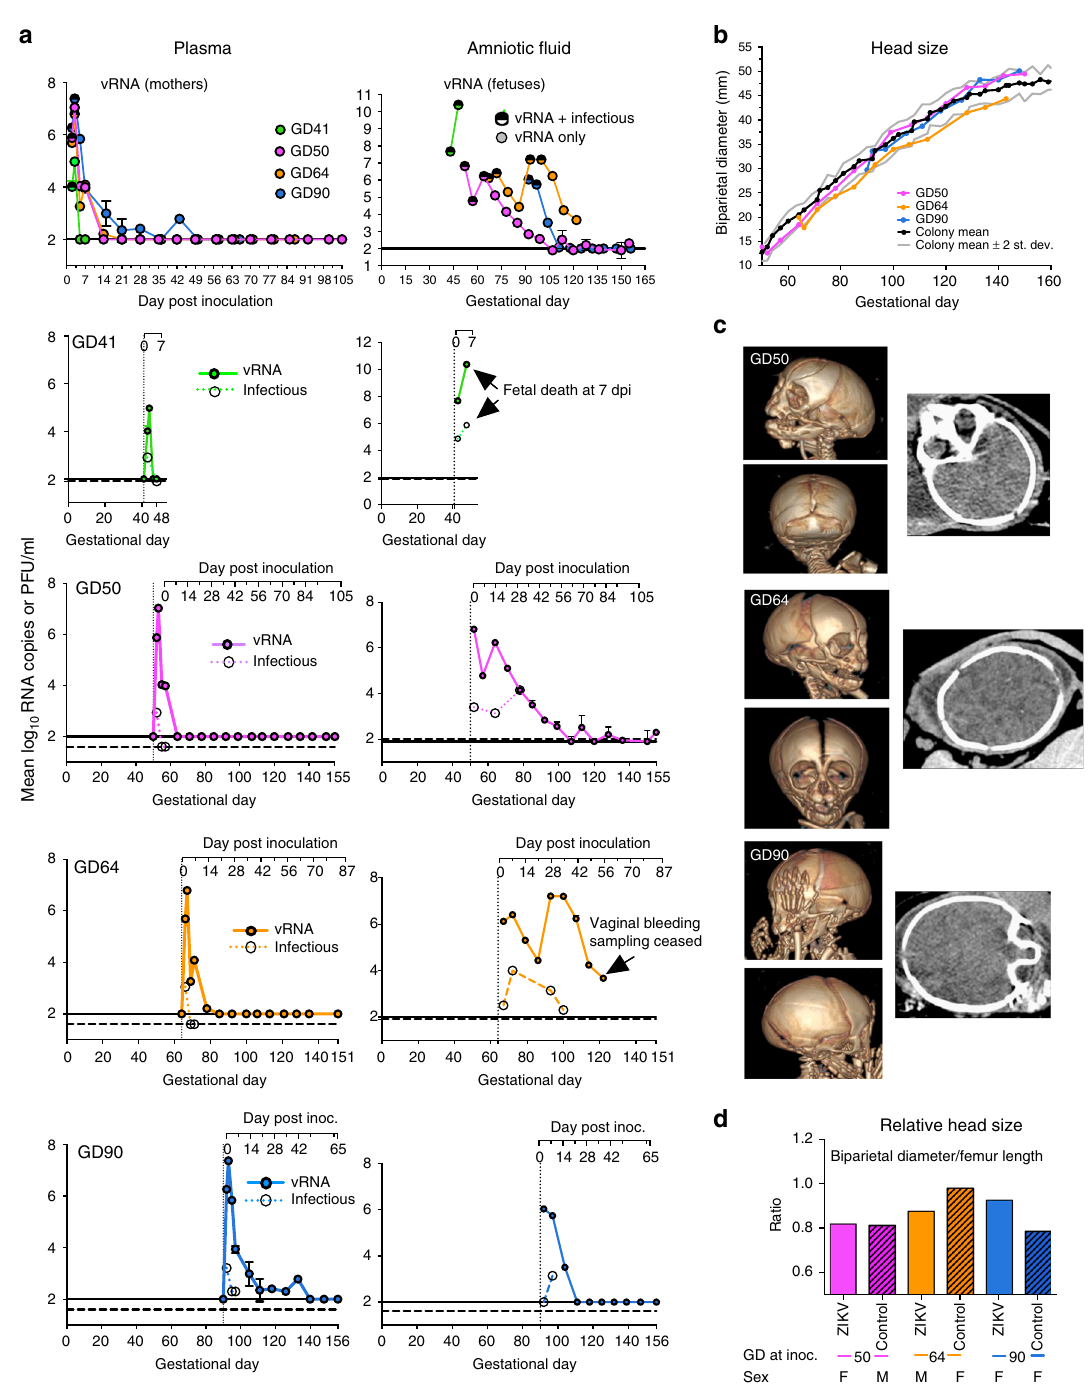
Fig. 2 Pregnant macaques inoculated IV and IA develop prolonged ZIKV viremias and ZIKV RNA in amniotic fl uid but show no fetal head growth restriction. a Viremia and ZIKV RNA levels in plasma and amniotic fl uid of ZIKV-infected pregnant rhesus macaques: Each line shows ZIKV RNA (solid lines) or infectious virus (dotted lines) kinetics for a single animal, detected in mean log 10 RNA copies assayed in triplicate with error bars showing standard deviations or mean log 10 Vero cell plaque forming units (PFU) per ml assayed in duplicate. The horizontal solid line shows the ZIKV RNA limit of detection (LOD) of 2.0 log 10 RNA copies and the horizontal dotted line shows the plaque assay LOD of 1.6 or 1.9 log 10 PFU per ml. For the GD64 mother, due to recurring placental bleeding, amniotic fl uid was no longer collected after 56 dpi (GD 120). b – d Most ZIKV-infected fetuses show normal growth as measured by head size determined by b the biparietal diameter at weekly ultrasound compared to the CNPRC colony mean (black line) ±2 s.d. (upper and lower gray lines), which was based on 10 – 100 fetuses reported earlier 60 , c computed tomography (CT) scans at GD 141 – 148 and d relative head size calculated as the biparietal diameter divided by the femur